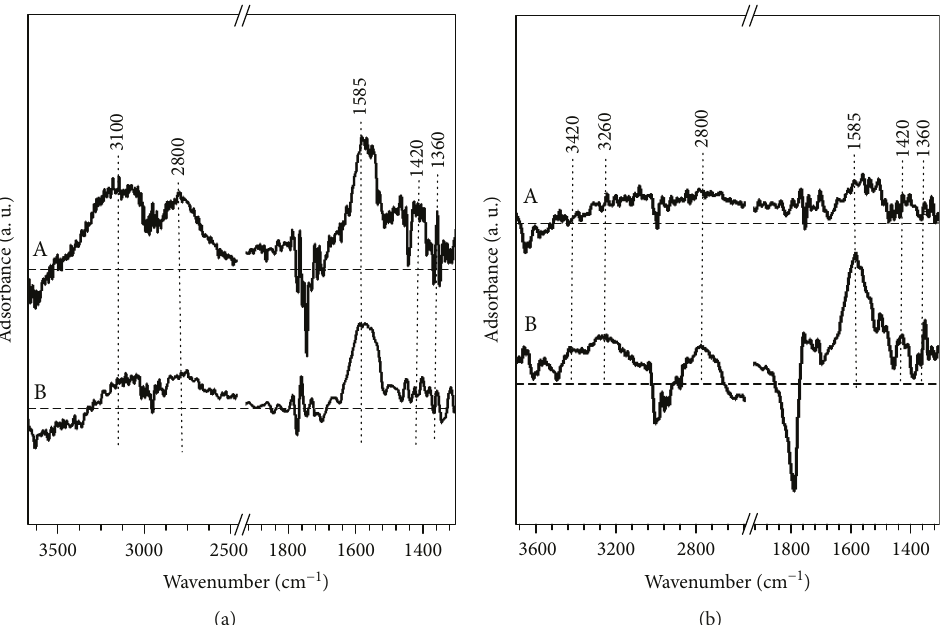
Figure 7: DR-FTIR subtraction spectra in the range 3700 – 1300 cm − 1 of outgassed samples at 10 − 2 mbar after interaction with NH P LA treated with continuous plasma (front) and (b) P (D,L)